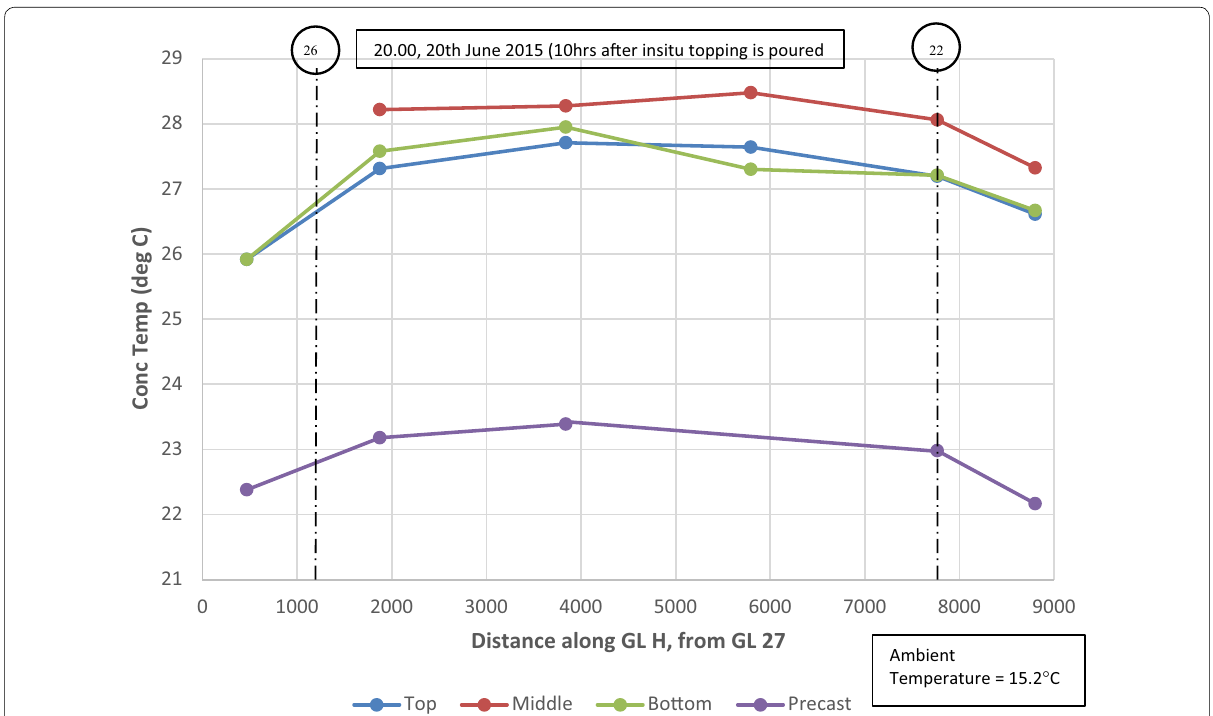
Fig. 12 Temperature distribution in concrete slab along GL H at approximately peak temperature during hydration phase (20.00, 20 June